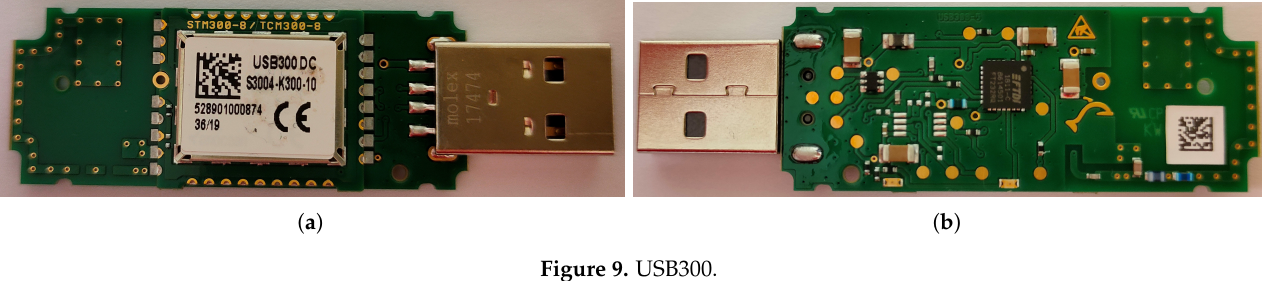
Figure 9. USB300.